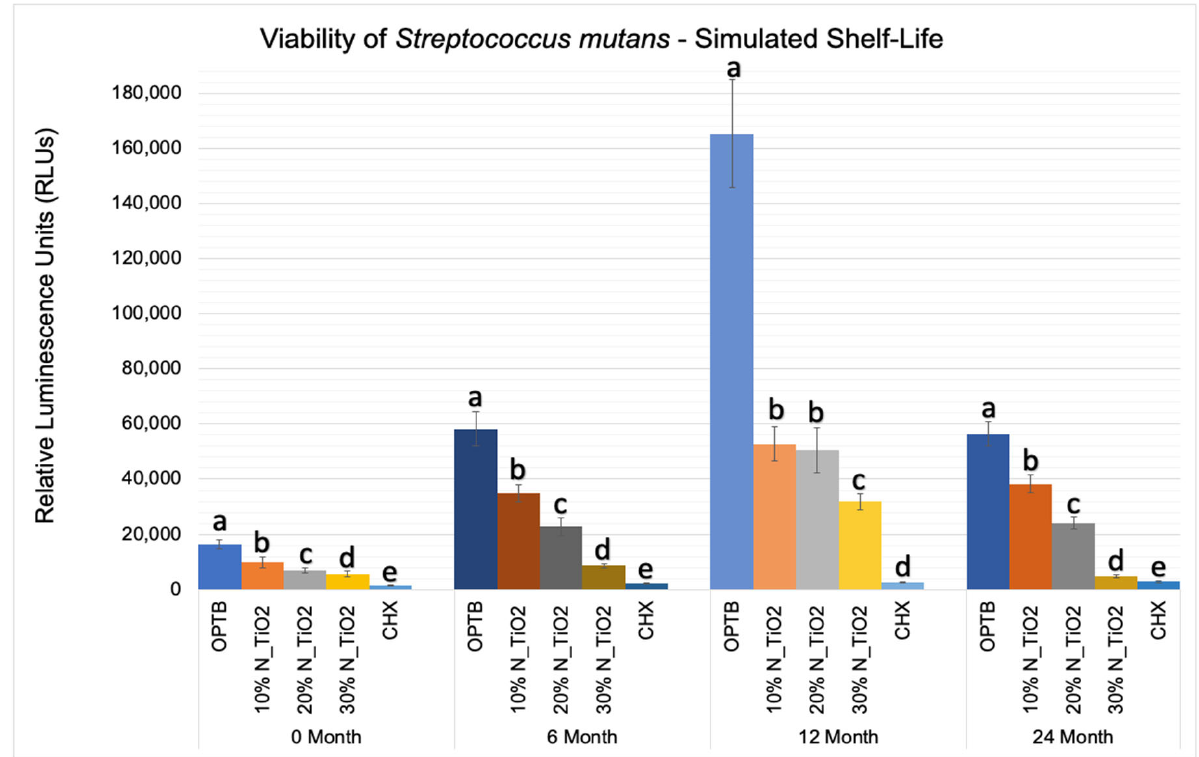
Figure 5. Expression of luciferase activity ( n = 18/group) was quantified in terms of bioluminescence. Biofilms on specimens that were fabricated from dental adhesives that were aged for 0, 6, 12, and 24 months had sustained lower bioluminescent values when exposed to higher nanoparticle concentrations. CHX is the positive control group. Letters above bars illustrate the SNK rankings and denote mean values that are statistically different ( p < 0.001) within timepoints of 0, 6, 12, and 24 months.